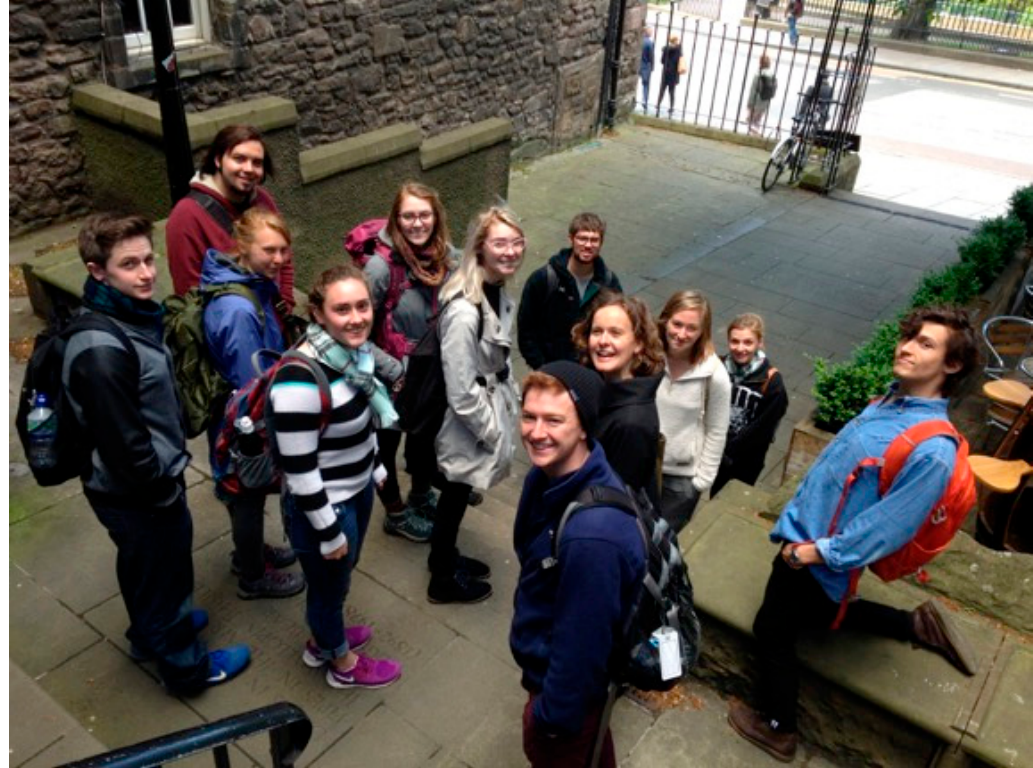
Figure 3. Dr. Tawny Paul, University of Exeter, leads Ohio University students on a tour of Edinburgh’s Old and New Towns (Photo by G.L. Buckley, June 2015).